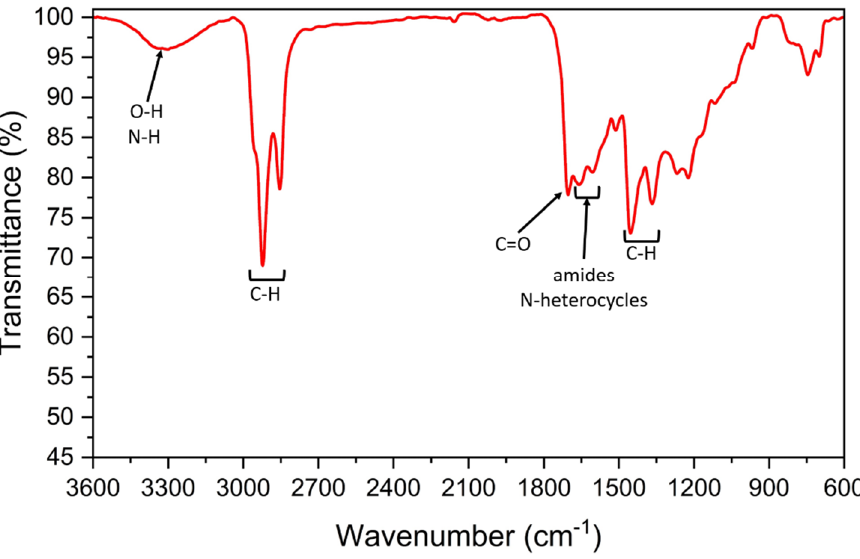
Figure 5. FT-IR spectrum of SS biocrude.